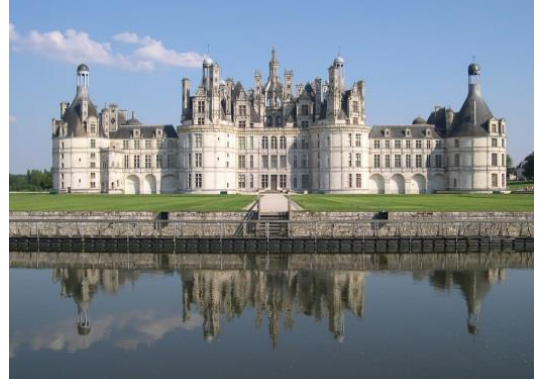
Photogrammetry and Deformation Measurement) at the French National School of Geographic Sciences (ENSG).